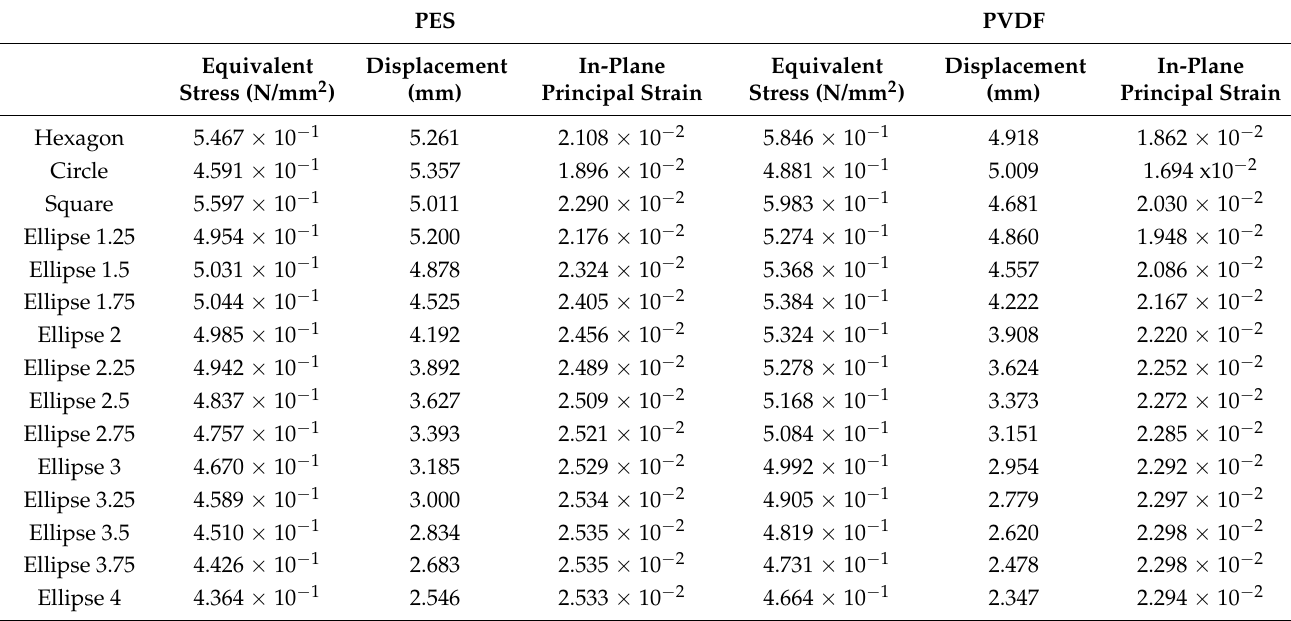
Table 3. Numerical analysis results of pure PES and PVDF membranes in different geometries. PES